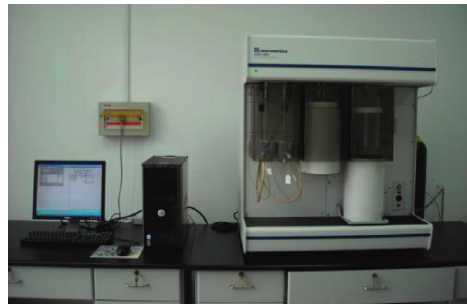
Figure 3: Automatic specific surface area and porosity